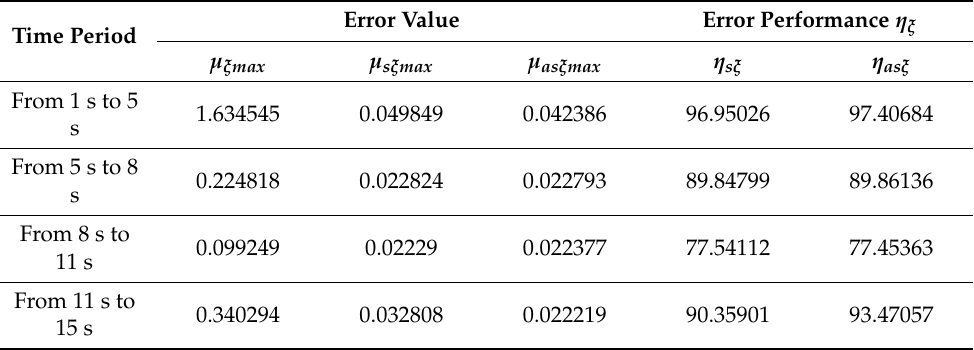
Table 2. An evaluation of the error performance using the fault compensation compared to the PID